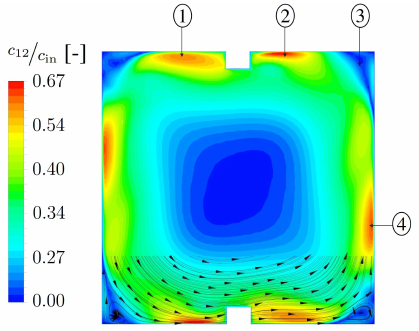
Figure 7. Normalized secondary flow velocity at x 3 / d h = 14, view in flow direction.